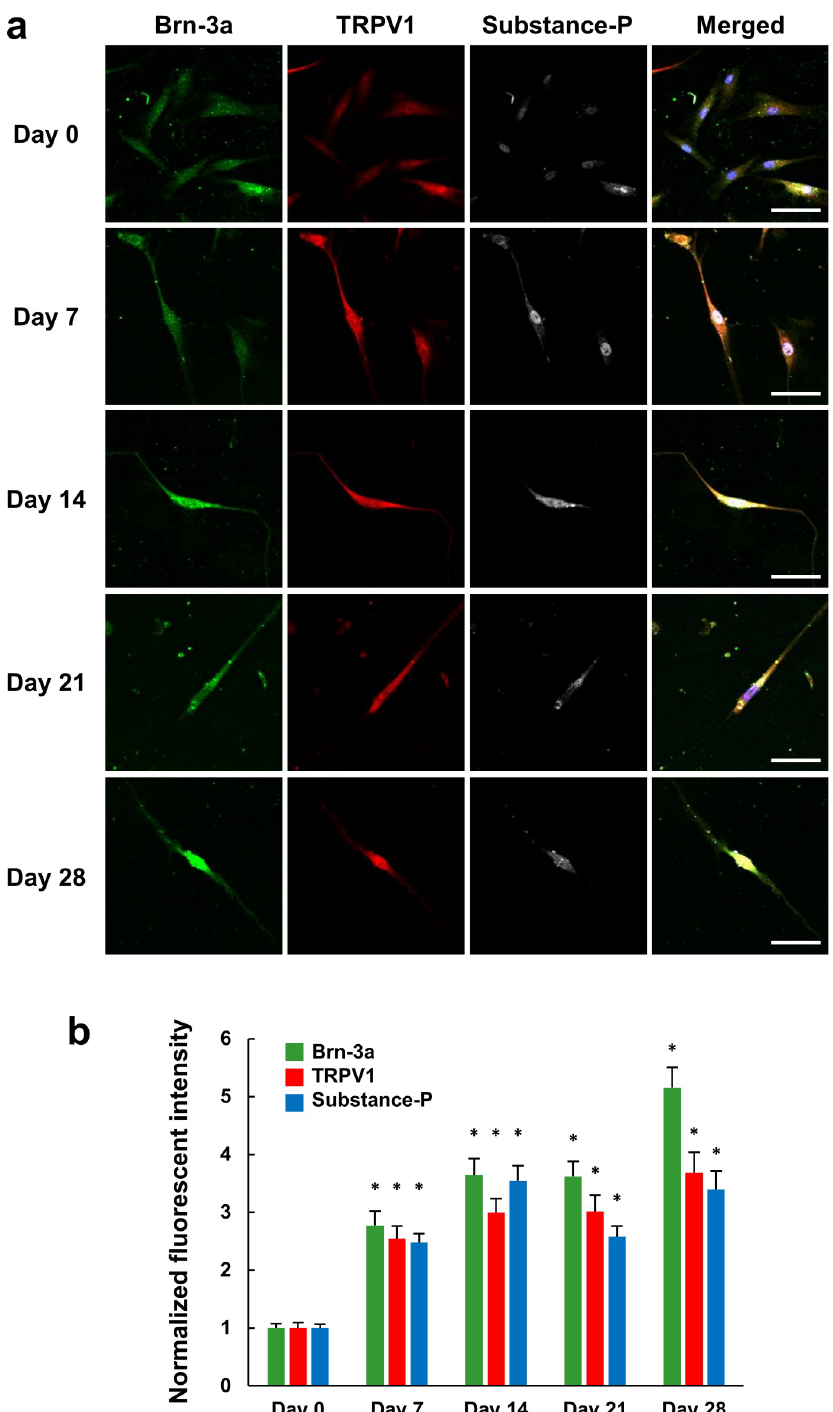
Fig 2. Immunofluorescence characterization of the neural differentiation of hDPSCs by peripheral neuron markers. (a) Confocal immunofluorescent images showing Brn-3a (green), TRPV1 (red), substance-P (white), and merged (DAPI: Blue, Brn-3a: Green, TRPV1: Red, substance-P: White) images of hDPSCs cultured in differentiation medium for 0, 7, 14, 21 or 28 days (Day 0, Day 7, Day 14, Day21 and Day28). Approximately similar changes in the expression levels were shown in 3–4 different experiments for each differentiation stage. Scale bar, 10 μ m. (b) Changes in expression levels of Brn-3a, TRPV1, and substance-P during the differentiation process (n = 52, 53, 50, 52, or 48 cells from 3–4 different dishes per differentiation stage, respectively). The values were normalized by the averaged